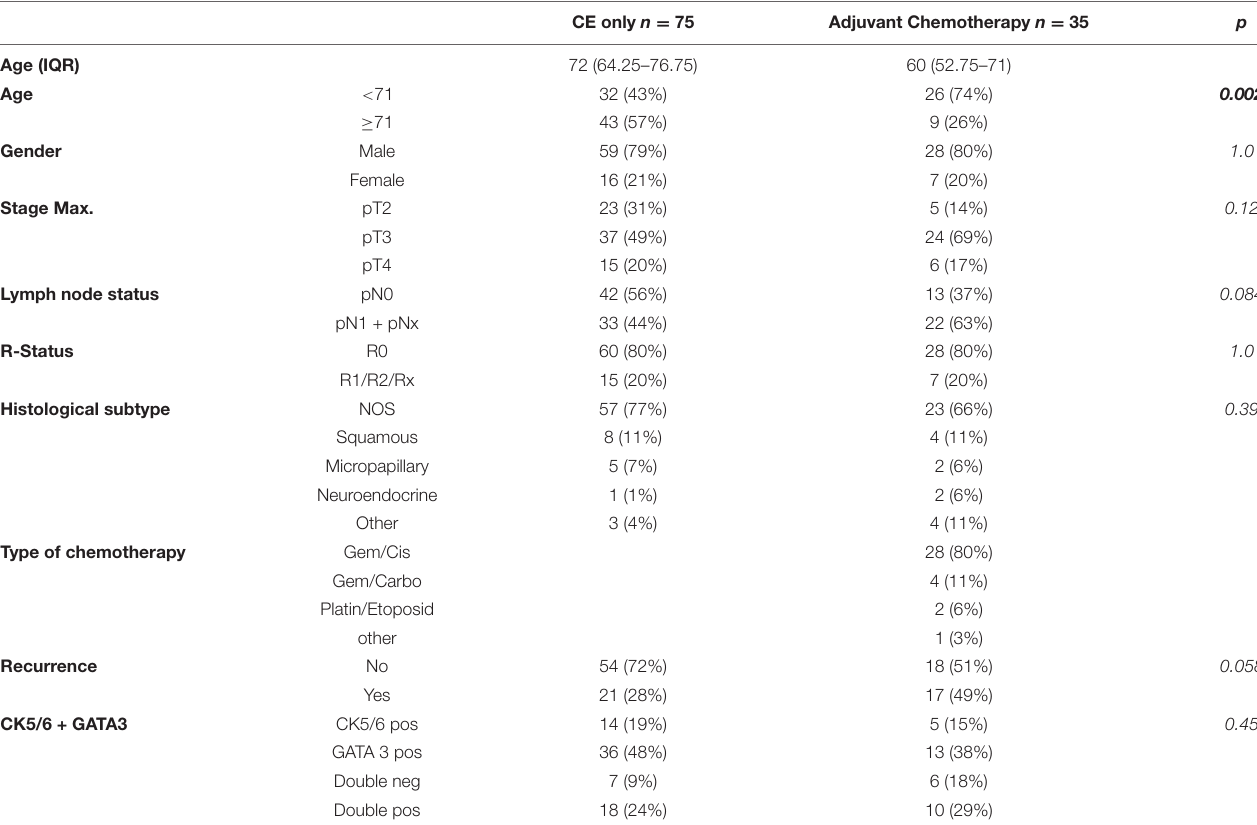
TABLE 3 | Characteristics of patients with and without adjuvant